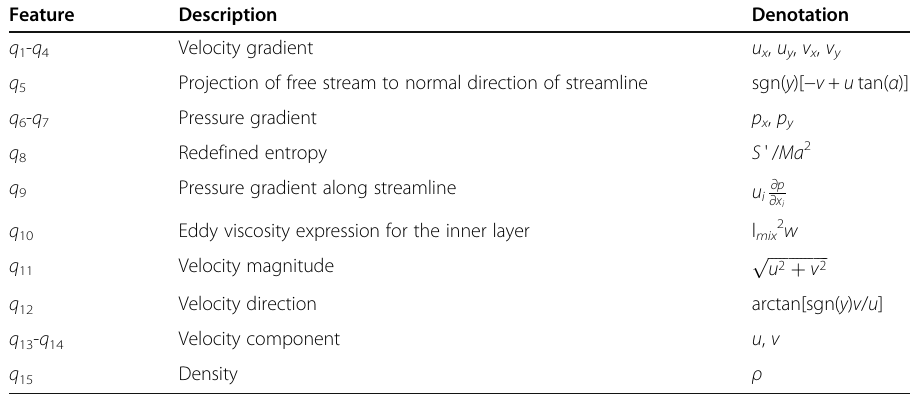
Table 2 The total candidate features Feature